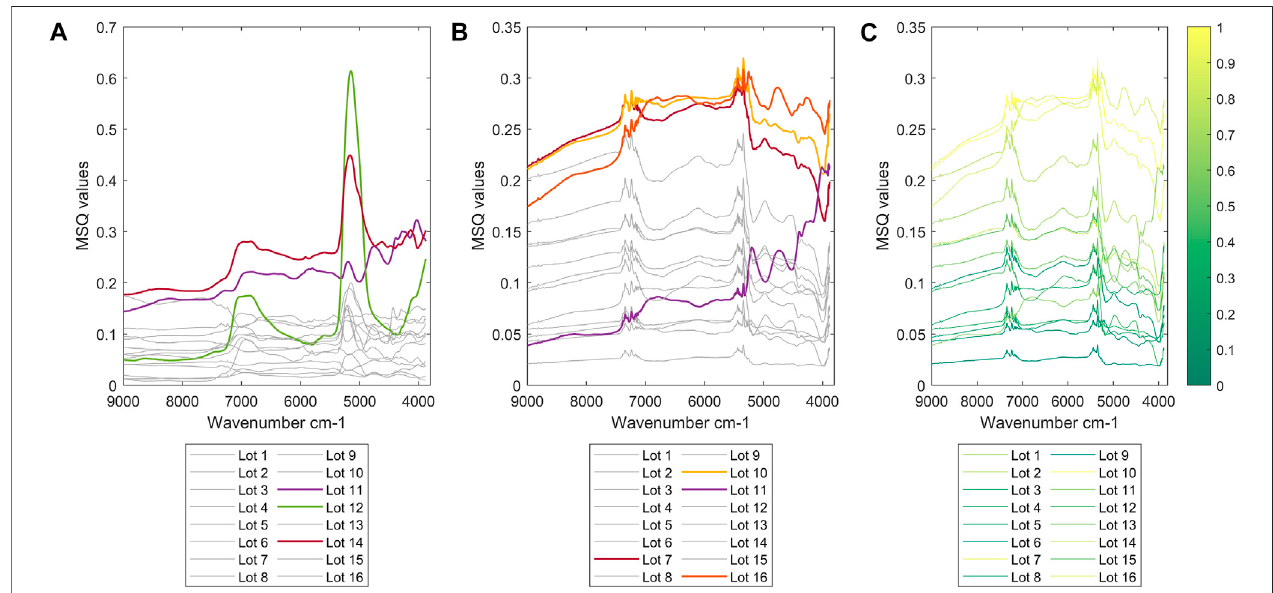
FIGURE4| The MSQvalues ofthenested analysisofvariance computedwithin each lot (A) at subsamplelevel and (B) replicate samplinglevel. MSQvalues at the replicate sampling level are also colored according to the distance in the PCA score plot between the two replicates of a sample (C) .